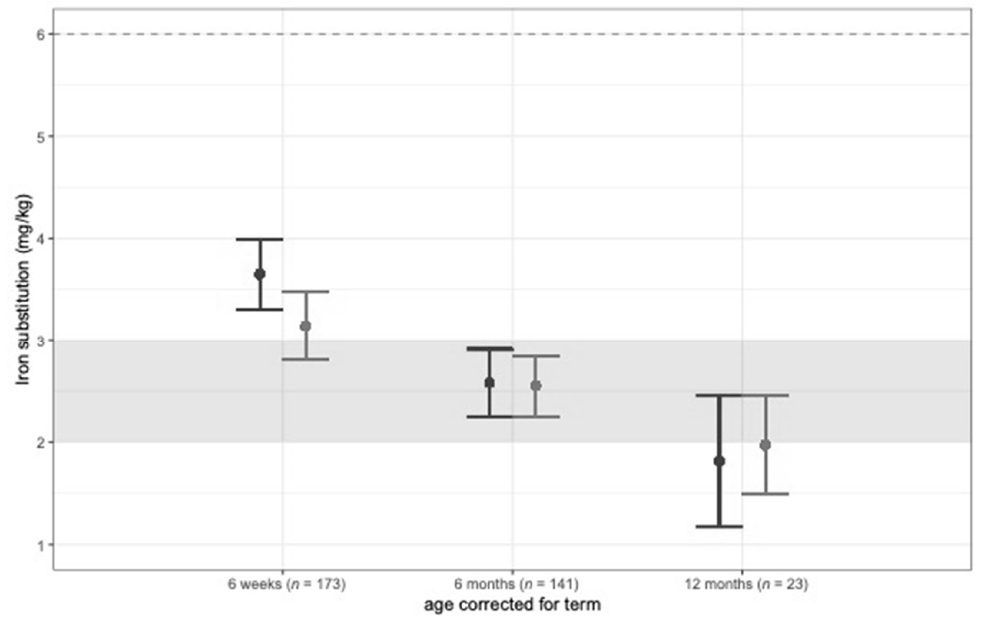
Figure 2. Iron supplementation (mg/kg/d) at 6 weeks, 6 months, and 12 months corrected age. At 6 weeks corrected age, hemoglobin levels were significantly lower in the early group despite a significantly higher iron intake by supplements. Upon correction for multiple test- ing, none of these two differences remained significant. All other hematologic parameters where comparable between the two groups at 6 weeks, 6 months, and 12 months corrected age, respectively. At 12 months corrected age, only a small number of patients (early group n = 7, late group n = 16) still received iron supplementation indicating that differences between groups calculated by mixed model analysis should be interpreted carefully.